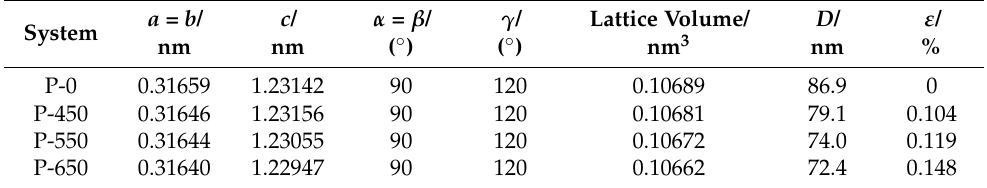
Table 3. Lattice constant, average grain size ( D ), and microstrain ( ε ) of nonactivated and microwave activated molybdenite.